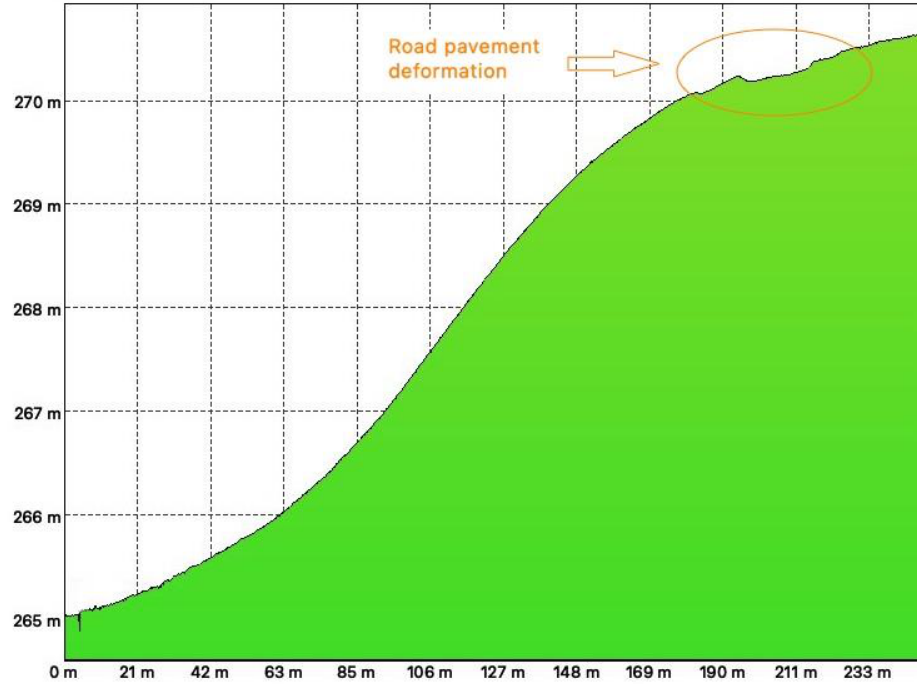
Figure 16. Longitudinal profile of the section shown in Figure 15 together with the marked section of the deformed road surface.